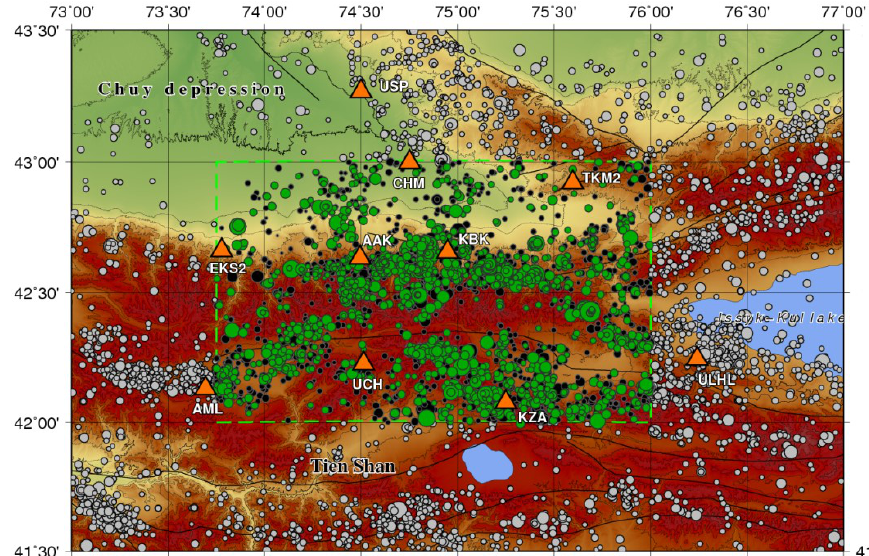
Fig. 2 . The earthquakes location of according to the data of the KNET network. The green rectangle (dashed line) is the territory bounded by the coordinates of the edge stations of the KNET network. Earthquakes for which the focal mechanisms are determined by the polarity of arrivals of seismic waves (1674 events) are marked in